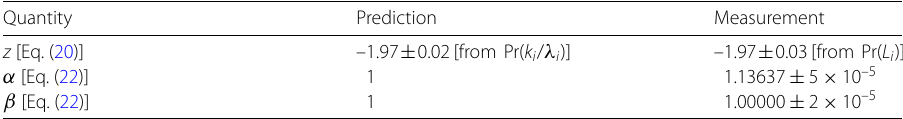
Table 2 Quantities predicted by the model against measured counterparts Quantity Prediction Measurement z [Eq.